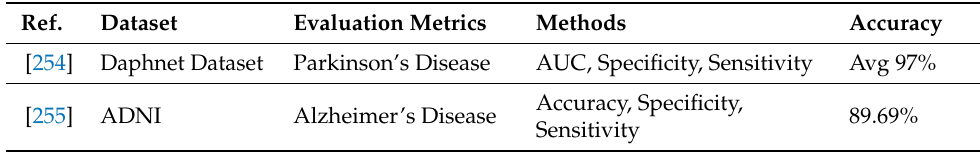
Table 15. RNN classifier result analysis on various NDs.